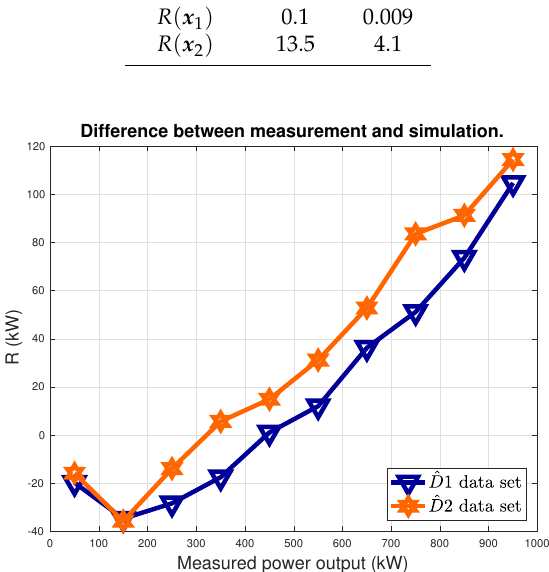
Figure 10. The average difference R between power measurement y and estimation ˆ y (Equation (11)). Datasets: D1 and D2. Sample run of the